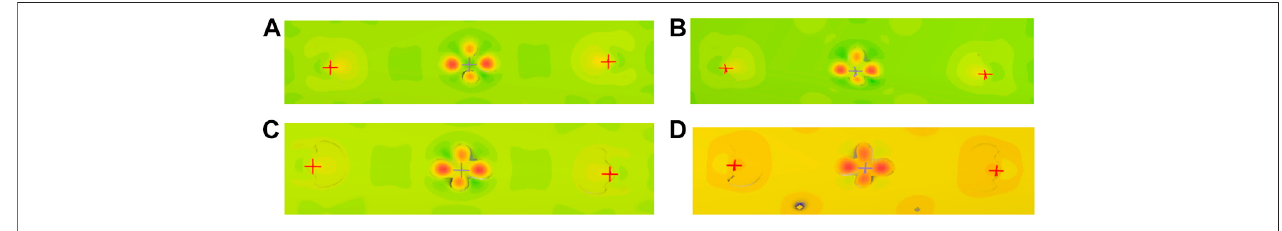
FIGURE 5 | Electron density difference of Li 1 − x Na x Ni 1/3 Co 1/3 Mn 1/3 O 2 . (A) When x (cid:2) 0, the color and coverage of the electron cloud around atoms are shown. (B) When x (cid:2) 0.01 mol, there is no difference for the color between x (cid:2) 0.01 mol and x (cid:2) 0 mol, and the coverage of the electron cloud expands. (C) When x (cid:2) 0.05 mol, its color gets darker. (D) When x (cid:2) 0.10, the orange color indicates that its conductivity is improved extremely.